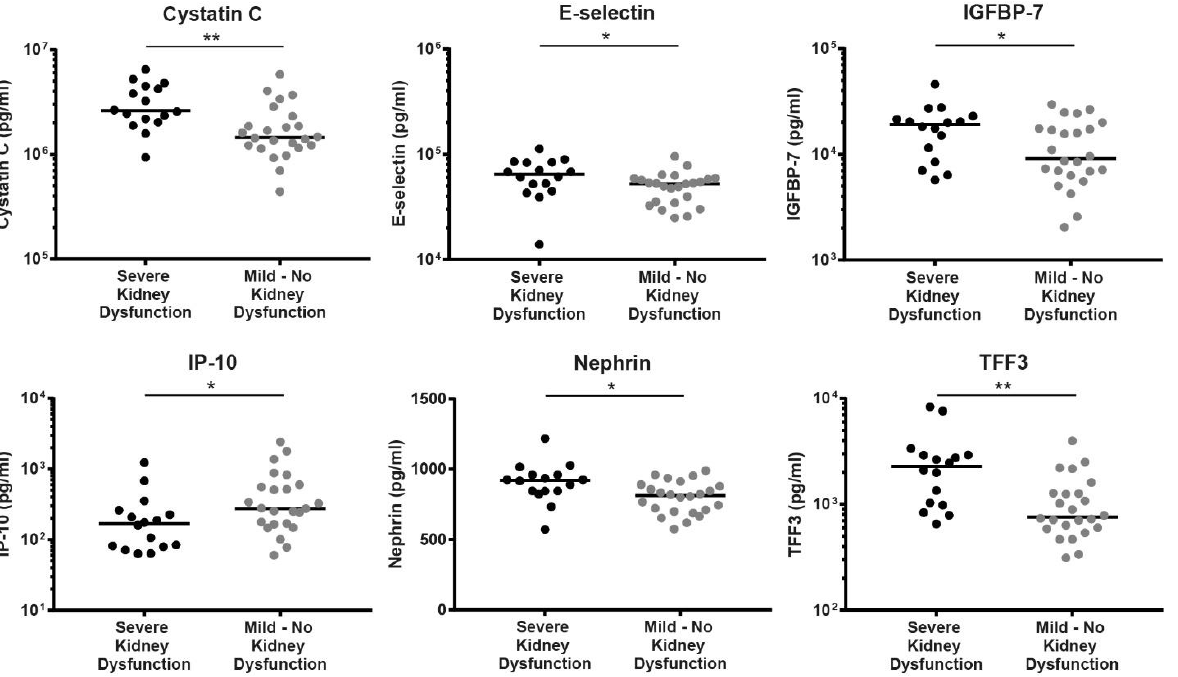
Figure 2. Serum markers correlated with severe kidney dysfunction in PUUV patients. Patients with severe kidney dysfunction were identified by eGFR-values <30 m/min/1.73 m 2 . Statistical signifi- cance was determined by the Mann – Whitney U test; *, indicating a p -value <0.05, and **, indicating a p -value < 0.01, were considered statistically significant. Abbreviations: IGFBP-7, insulin-like growth factor-binding protein 7; IP-10, interferon gamma-induced protein 10; TFF3, trefoil factor 3.